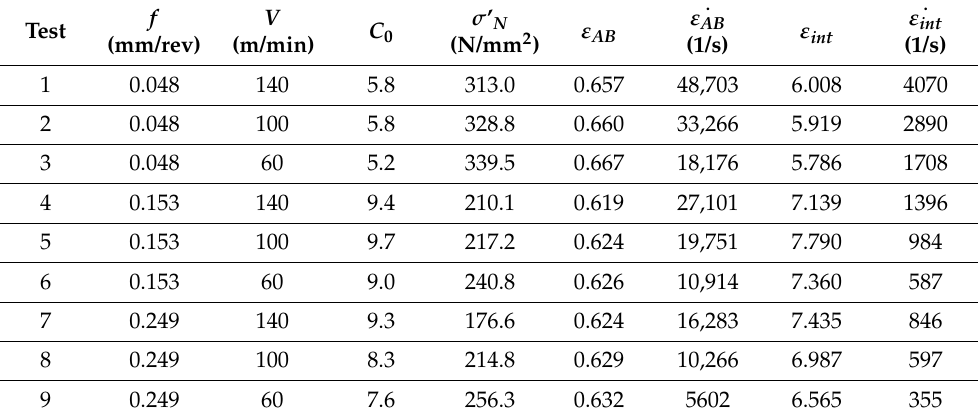
Table 10. The values determined for a p = 0.5 mm, α = 7 ◦ .